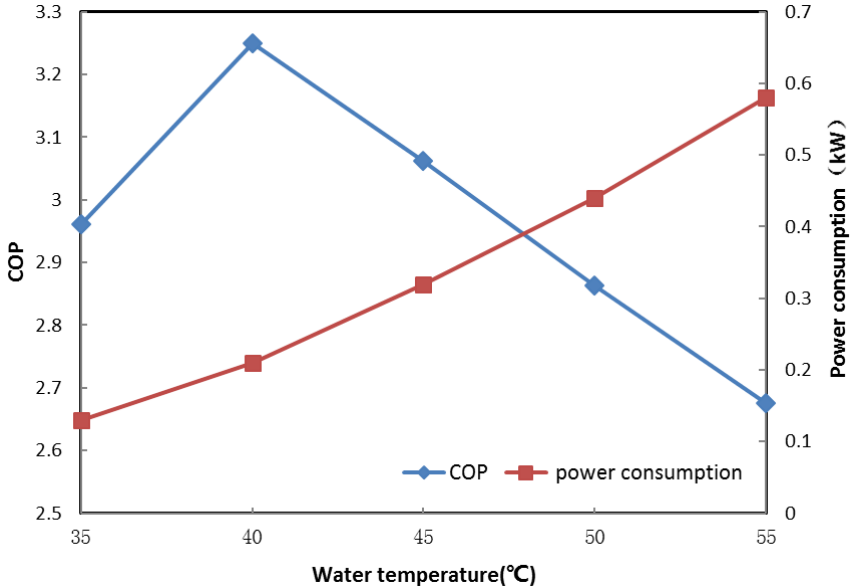
Figure 4. Coefficient of performance (COP) values and power consumptions of the WSHPWH system.